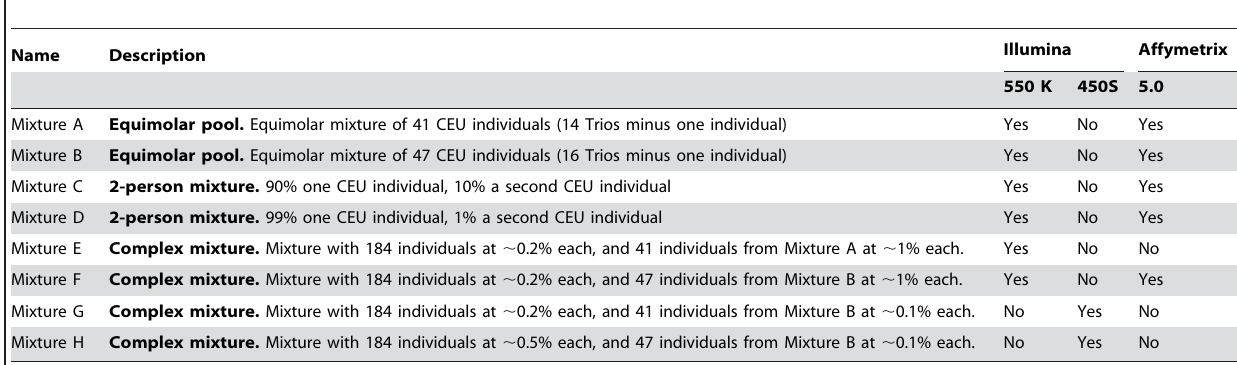
Table 1. Mixtures are composed partially of HapMap individuals empirically evaluated on the Illumina 550 K v3, Illumina 450S Duo, and Affymetrix 5.0